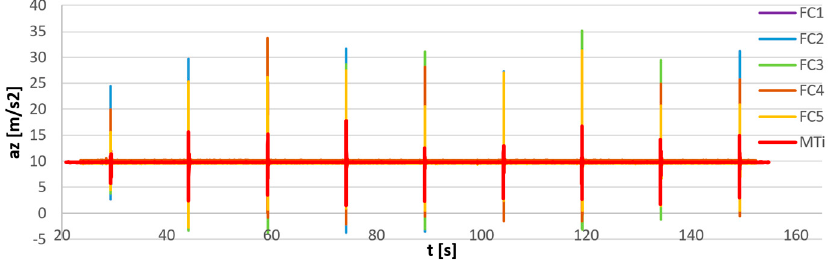
Figure 14. Measurement of impulse excitation of five flight controller sensors (FC1–FC5) after synchronization and reference signal measured with the Xsens MTi-G700 sensor (MTi).